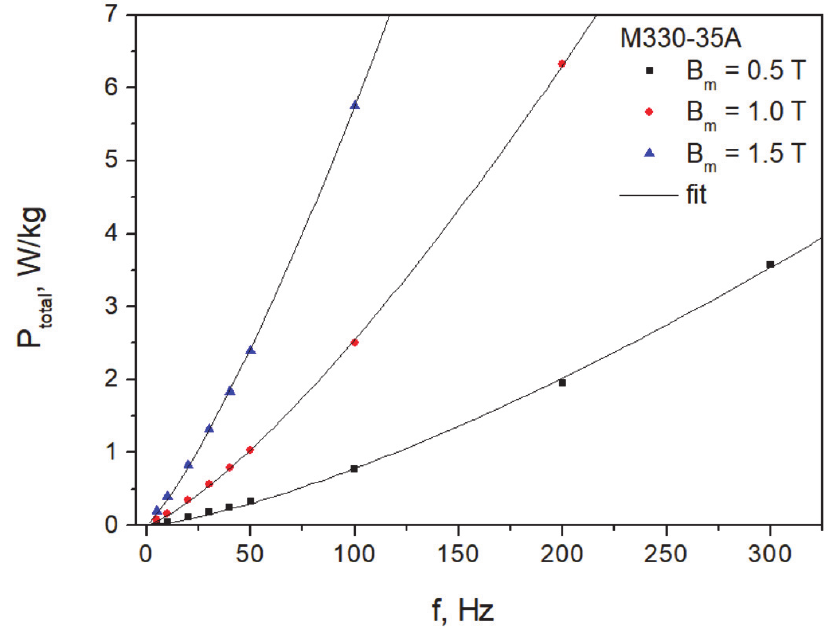
Figure 12. Measured and modeled P total = P total (f) dependencies for the M330-35A steel. Fit was Figure 11. Measured and modeled P total = P total (f) dependencies for the M330 ‐ 35A steel. Fit was car ‐ carried out using a fixed value of coefficient in the power law for dynamic ried out using a fixed value of coefficient in the power law for dynamic loss.